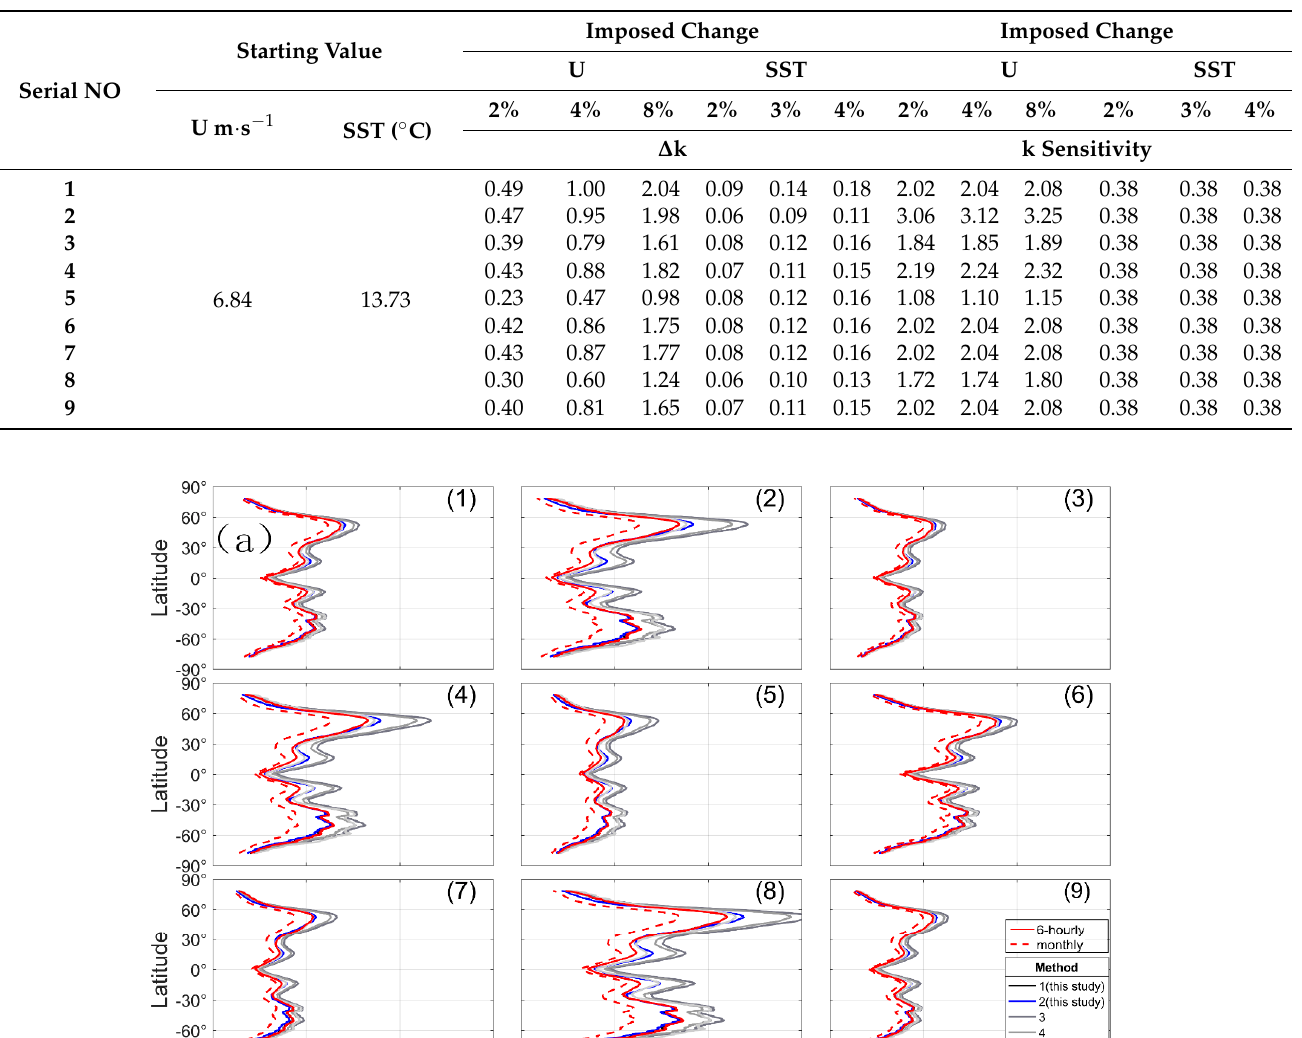
Table 3. Parameters used to run scenarios of imposed changes in wind speed (U) and sea surface temperature (SST) and their effects on the gas transfer velocity (k) for the nine k parameterizations featured in Table 1. The starting values of U and SST were set to 6.48 m s − 1 and 13.73 ◦ C, respectively, according to their climatological global mean. The sensitivities of k to U and SST were assessed from the ratio of the percentage change in k (Y) to percentage change in each factor (X) using the equation: sensitivity = ( ∆ Y/Y)/( ∆ X/X).